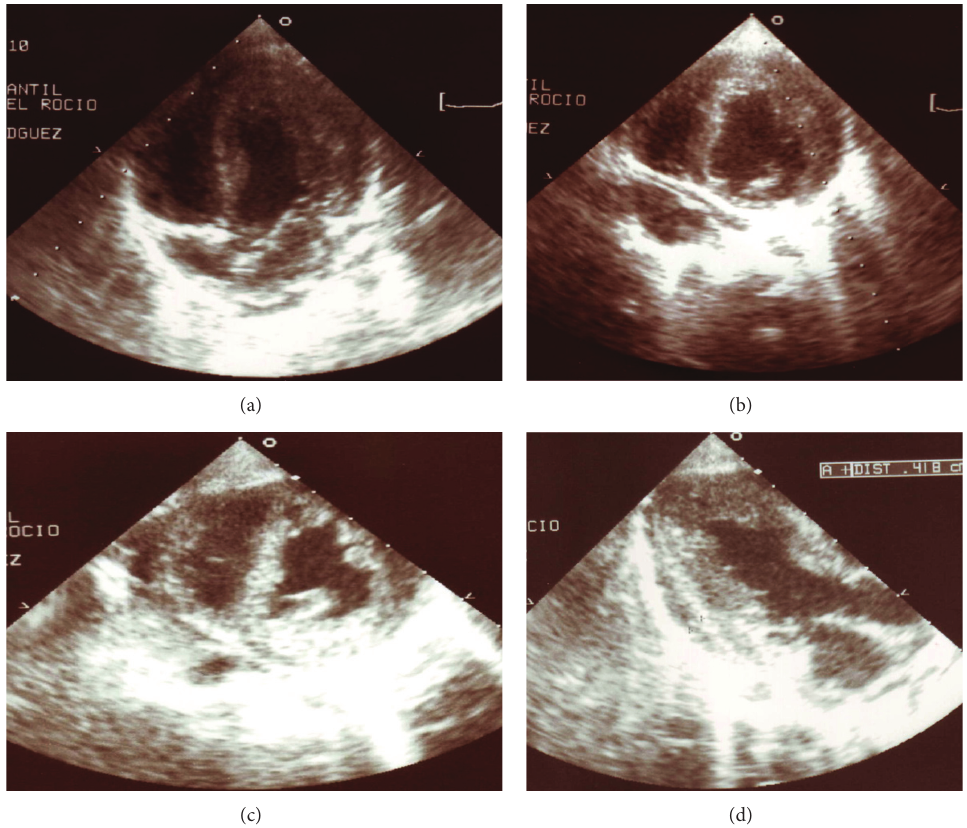
F 2: Neonatal echocardiography showing cardiac morphology similar to that in fetal echocardiography.